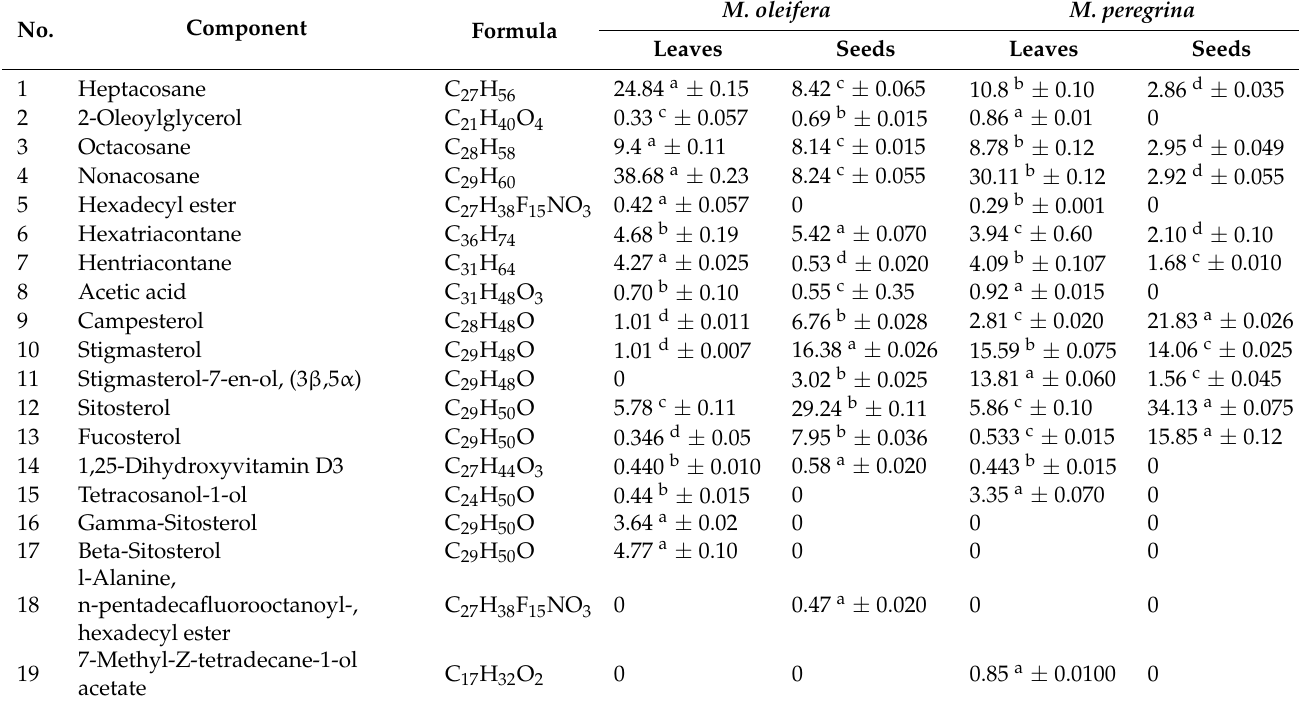
Table 3. Un-saponified composition (%) from leaves and seeds of M. oleifera and M. peregrina